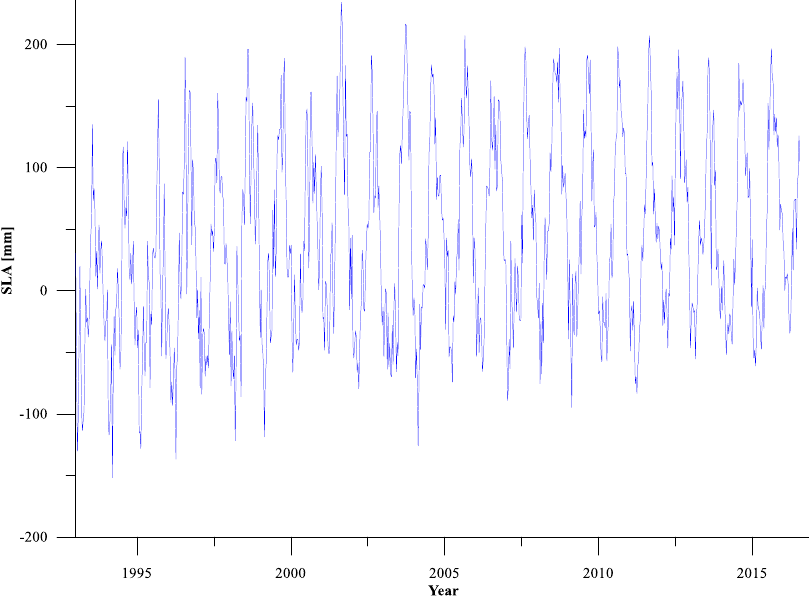
Figure 2. Weekly sea level anomaly (SLA) time series from 1993 to 2016 around Shandong Peninsula.